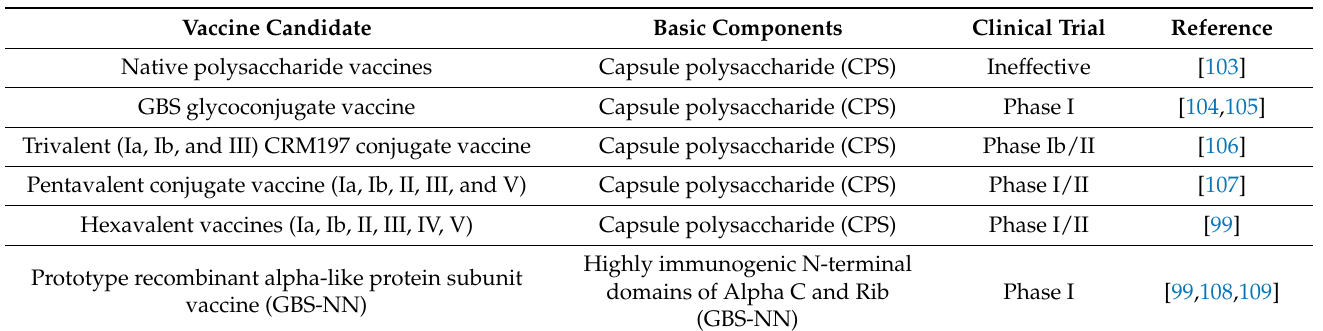
Table 3. Summary of GBS vaccines in clinical